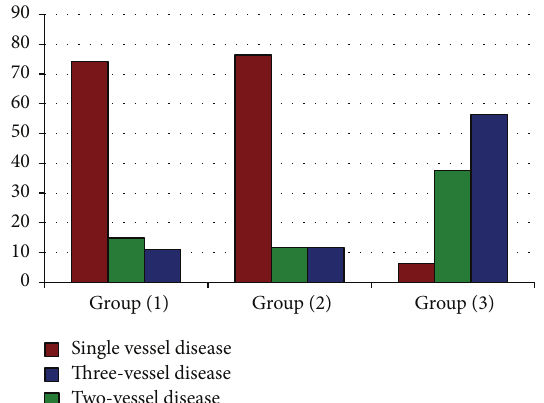
Figure 1: Number of diseased vessels in the study groups (1, 2, and